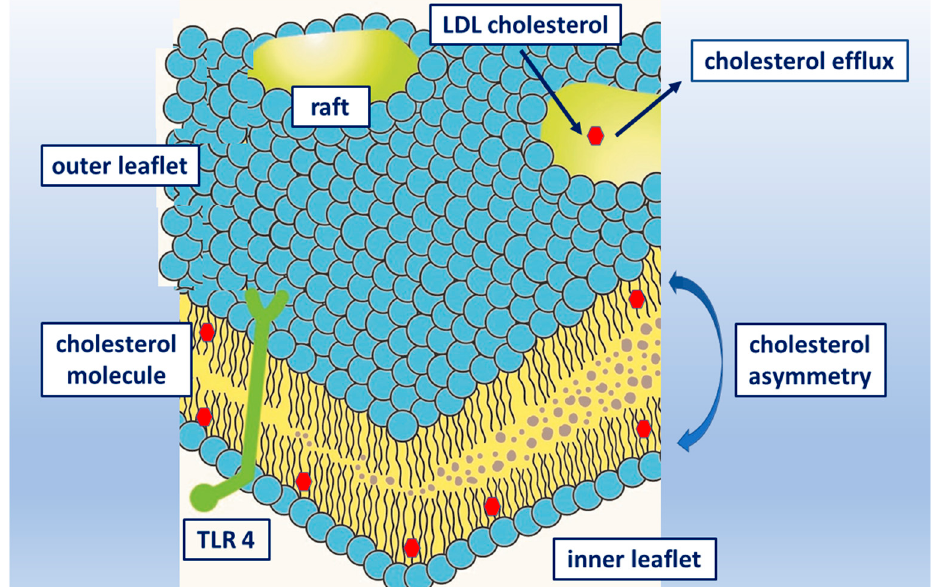
Figure 1. Schematic phospholipid bilayer cell membrane with cholesterol molecule (red symbol) and location of transmembrane receptor. Cholesterol asymmetry represents different proportions of cholesterol in the outer and inner phospholipid layers. Transport of cholesterol to the surface raft from plasma lipoproteins and possible reverse efflux.